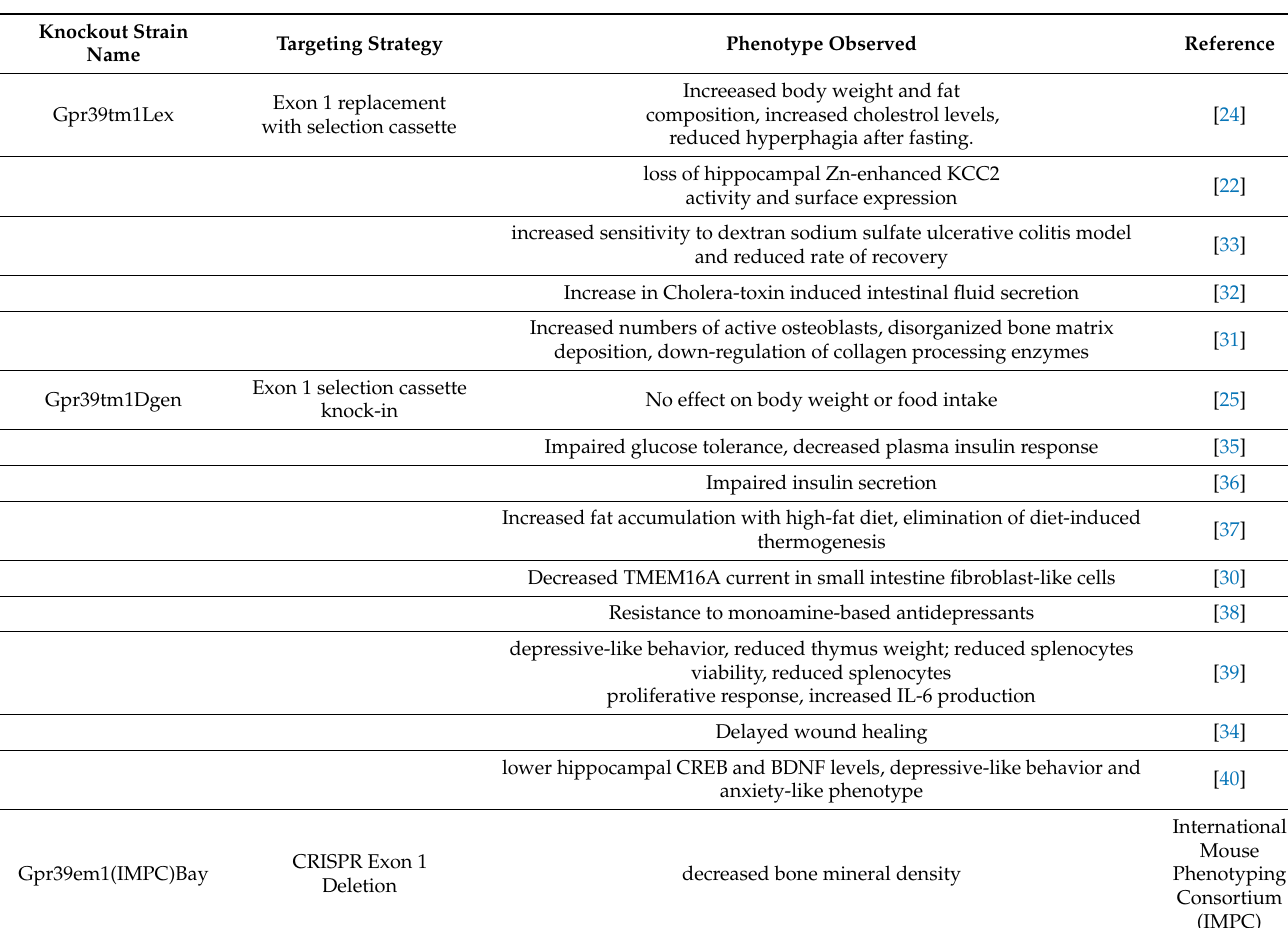
Table 2. Summary of GPR39 knockout mouse models. Disruption strategy and observed phenotypes are detailed for each GPR39 knockout line with respective